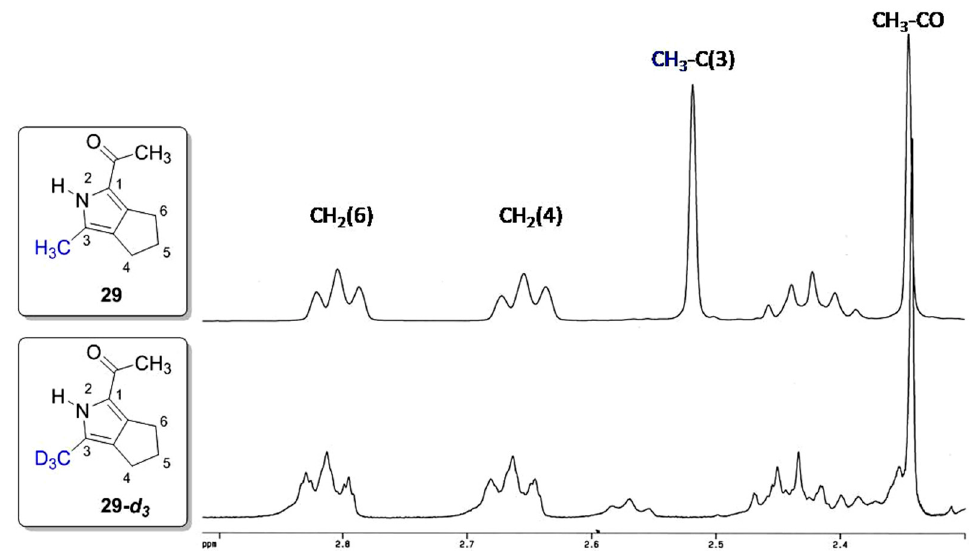
Figure 2. Comparison of the 1 H-NMR spectra of 29 and 29 - d 3 .